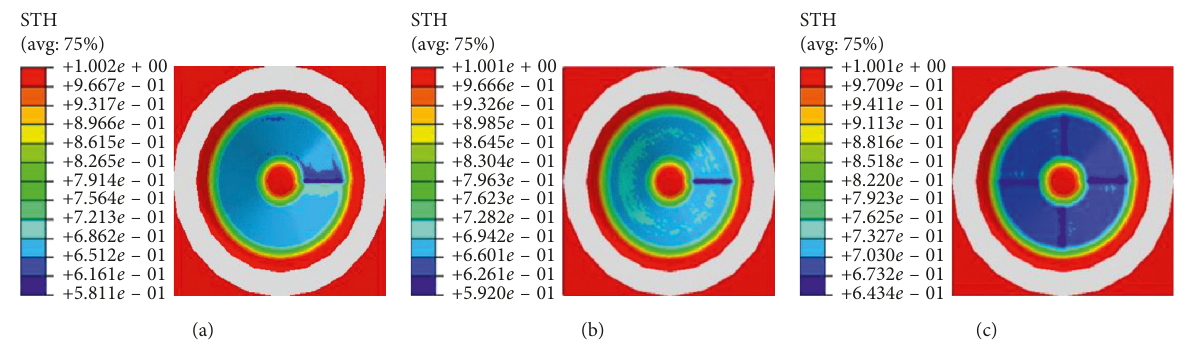
Figure 15: Simulation results of three forming trajectories: (a) single forming trajectory, (b) alternating inversion trajectory, and (c) uniformly press point trajectory.